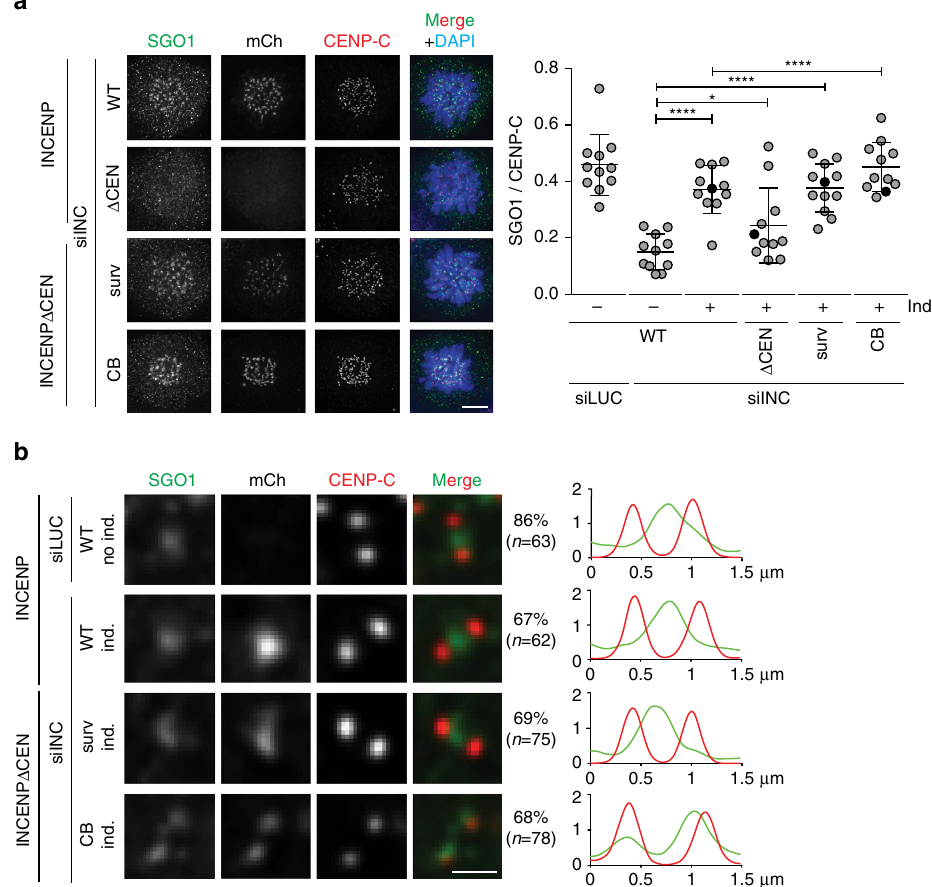
Figure 3 | SGO1 is predominantly localized at kinetochores in CB-INCENP expressing cells. ( a ) IF and quantification of fluorescence intensities (FI) of SGO1/CENP-C on centromeres and/or kinetochores in the depicted cell lines, transfected with the indicated siRNAs, and blocked in mitosis using STLC (1 exp. out of 2, 11 cells per condition, bars: mean ± s.d., ns, not significant; * P o 0.05; **** P o 0.0001; unpaired t test). DNA is visualized using DAPI. Scale bar, 5 m m. ( b ) Representative sister kinetochores with SGO1, mCherry and CENP-C and 1D line graphs of SGO1 (green) and CENP-C (red) of cells transfected with the indicated siRNAs, blocked in mitosis using STLC and expressing INCENP variants that rescued SGO1 centromere/kinetochore localization ( a ). The percentage of kinetochore pairs showing that particular SGO1 staining pattern is shown on the right side of the images. Scale bar, 1 m m. NATURE COMMUNICATIONS|8:15542|DOI: